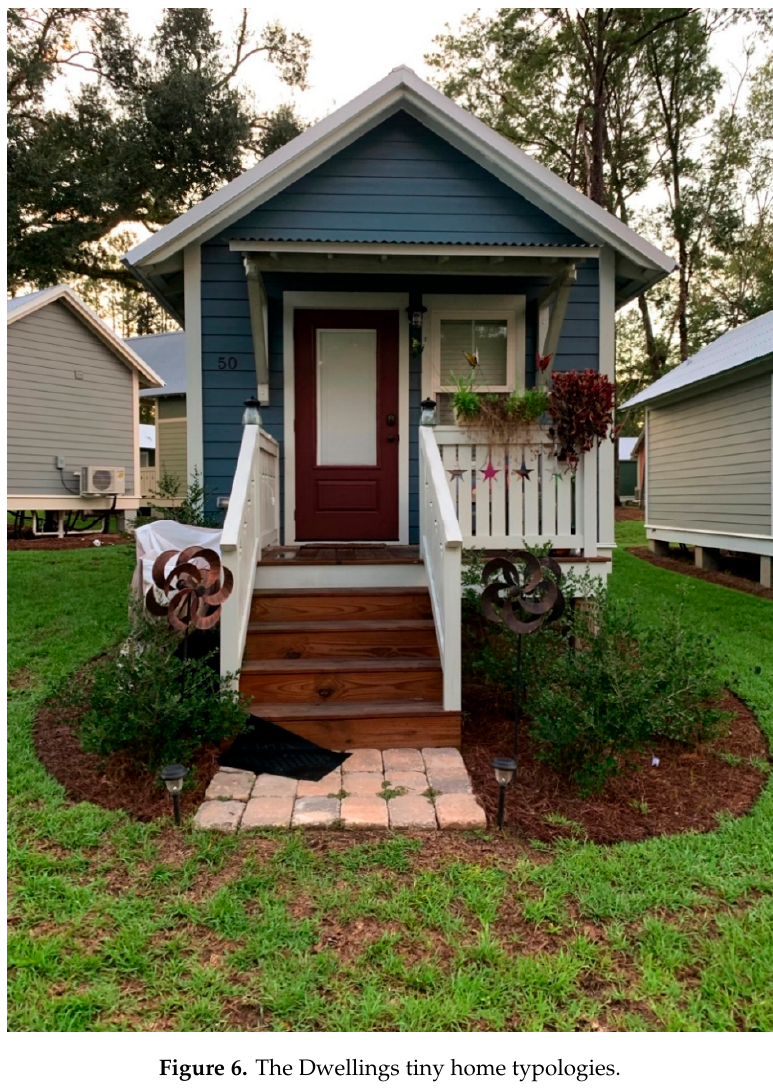
Figure 6. The Dwellings tiny home typologies.